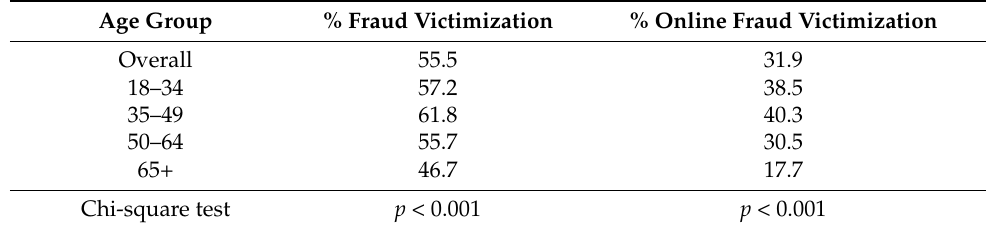
Table 2. Percentage of consumer fraud and online fraud victimization in weighted sample. Age Group % Fraud Victimization